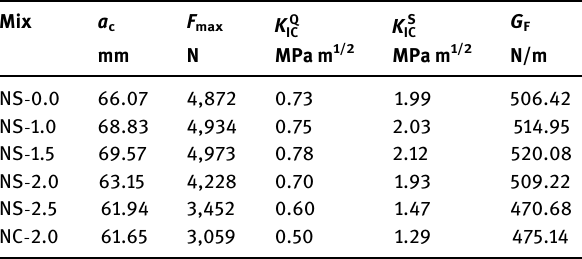
Table 7: Summary of fracture